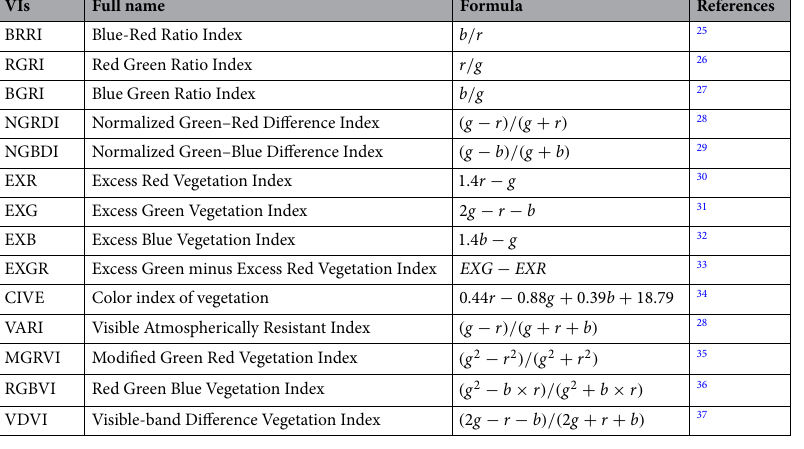
Table 2. RGB-based VIs for LAI